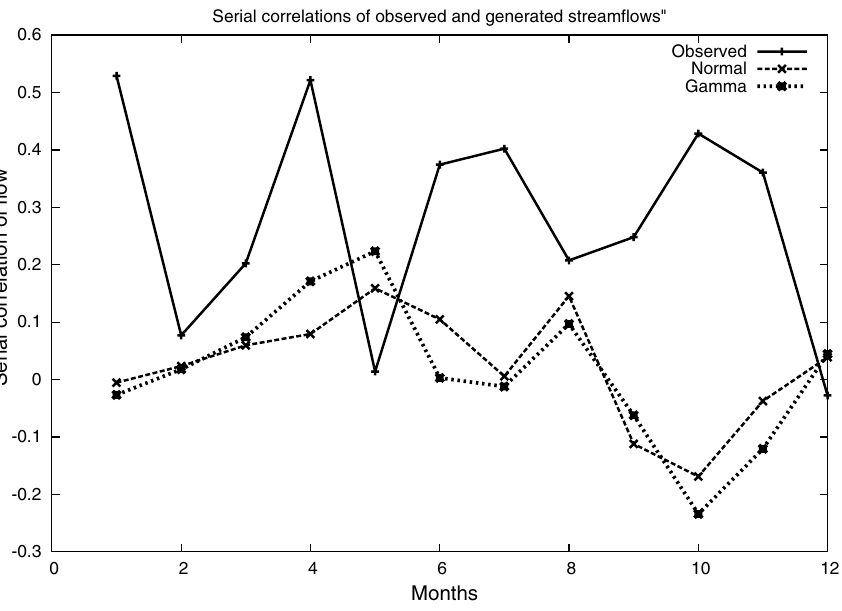
Fig. 14 Historical and generated monthly serial correlations of flows in Konar River (multi-site